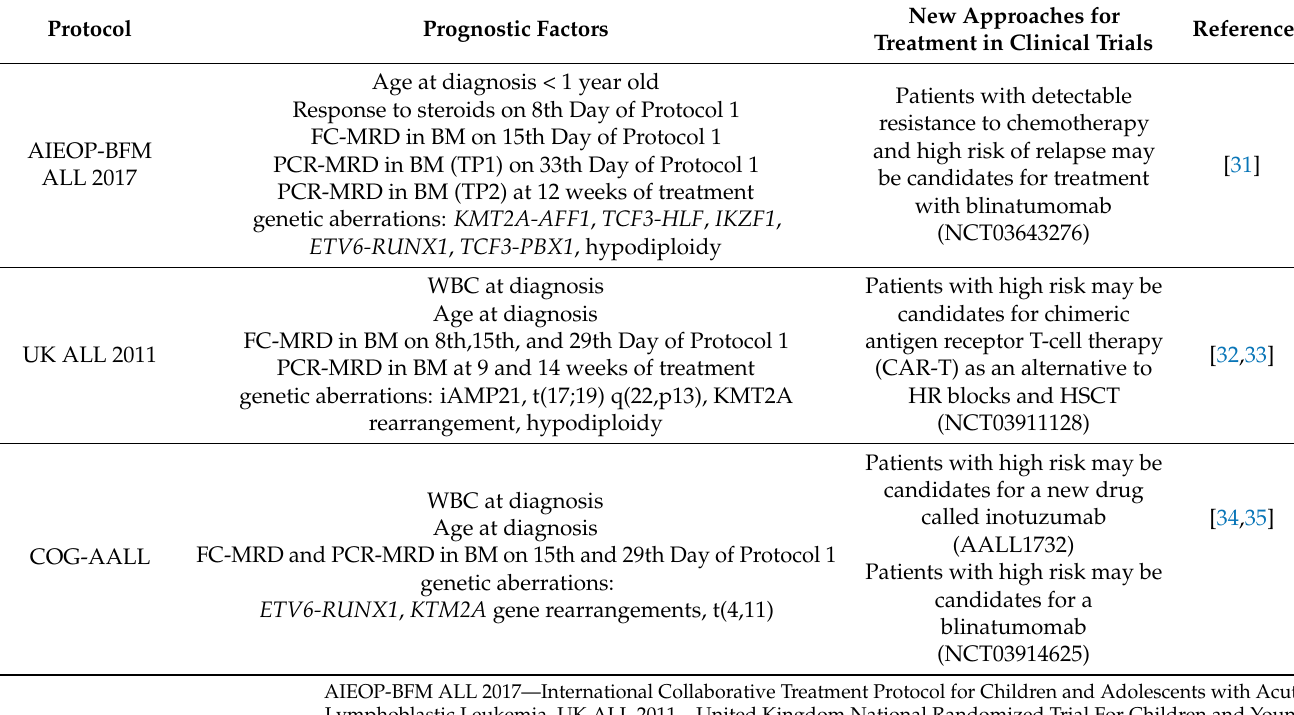
Table 1. Comparison of selected treatment protocols in regard to prognostic factors, time points, and new approaches for treatment in clinical